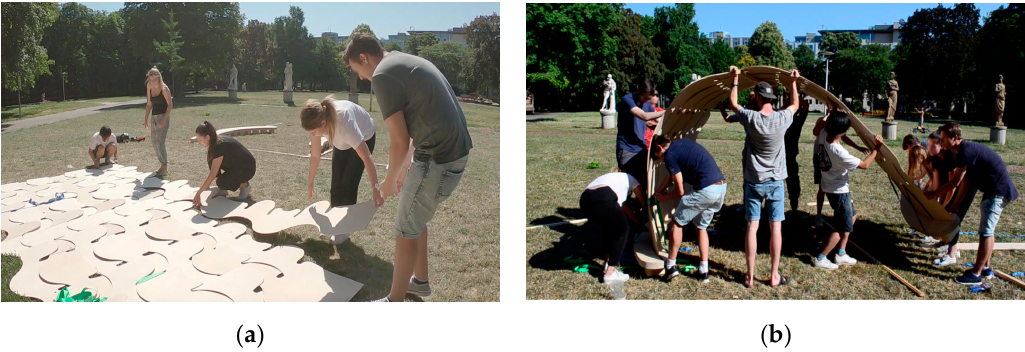
Figure 6. ( a ) Simple horizontal stacking by pushing modules into each other; ( b ) Erecting the pre-mounted pavilion by manual bending, and latter fixation with the curved foundations. © A. Coban and V. Ivanova; BioMat/ITKE-University of Stuttgart.